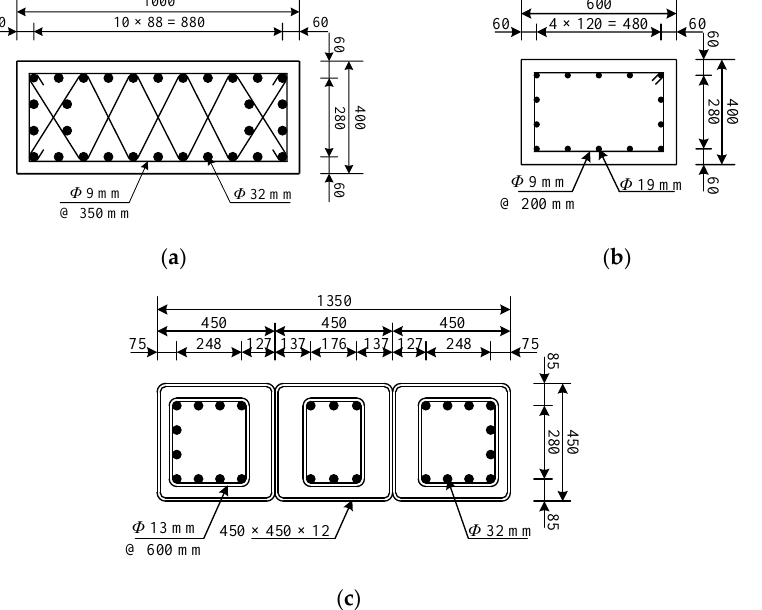
Figure 3. Section reinforcement of columns in original structures and the new station (unit: mm): ( a ) Reinforcement of columns in the original station; ( b ) Reinforcement of columns in the original tunnel; ( c ) Reinforcement of columns in the new station. Table 1. Section size and reinforcement of